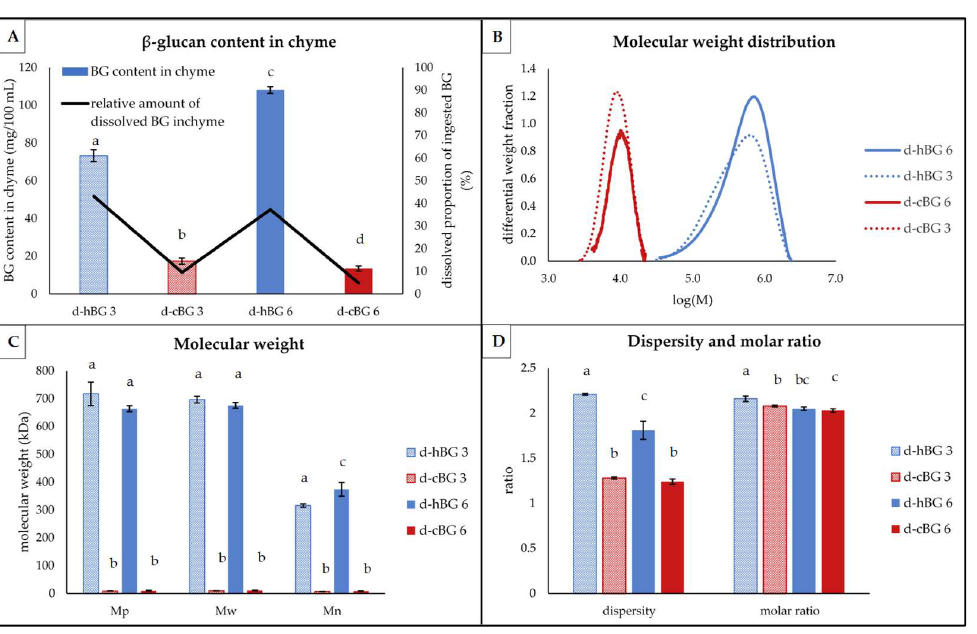
Figure 5. Structural characteristics of β-glucan (BG) present in digested breads breads fortified with 3% of high molar mass BG or control BG (d-hBG 3 or d-cBG 3) and 6% of high molar mass BG or control BG (d-hBG 6 or d-cBG 6) presented as: ( A ) BG content (bars) and proportion ingested BG, which got dissolved in the chyme; ( B ) molar mass distribution shown as differential weight fraction plotted against the logarithmic molar mass (M); ( C ) peak- (M p ), weight average- (M w ) and number average (M n ) molar mass; ( D ) dispersity and molar ratio. All values are shown as mean ± standard deviation ( n = 3, p < 0.05). Different lower-case letters indicate a significant difference between the breads for each characteristic.